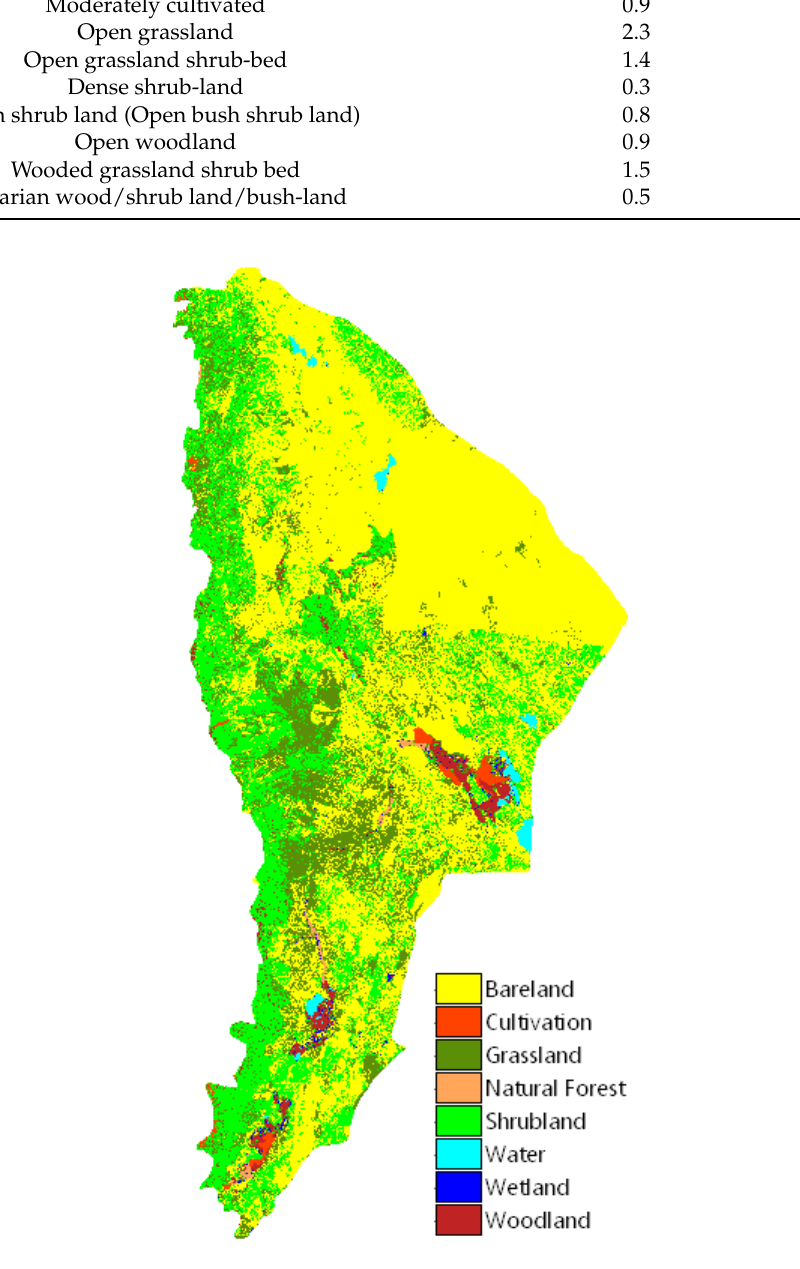
Figure 3. Afar Land Use Map (scale 1:5,500,000). Table 1. Rainfall dependent forage production functions.